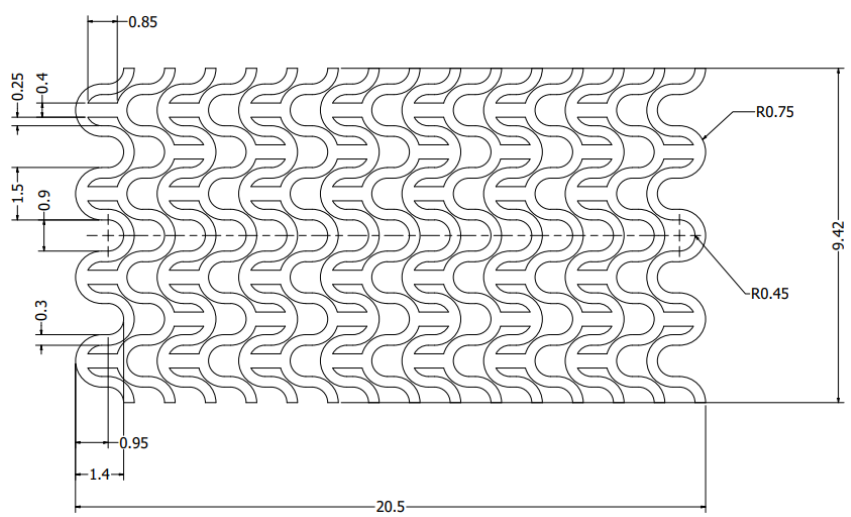
Figure 4. Sketch of the half of the geometry of the stent .